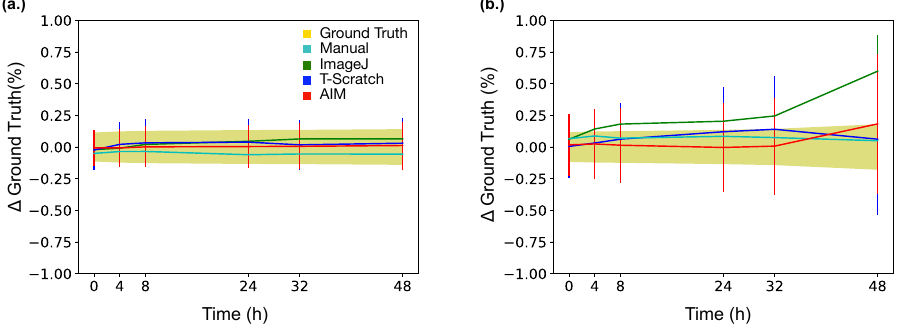
Figure 3. Representation of the average percentage difference from the ground truth as a function of time. In ( a ), the data relative to the control condition are shown; while in ( b ), the values computed for the TGF- β 1-treated cells are reported. The yellow shaded area represents the dataset’s variability and was computed as the standard deviation of the wound area obtained at every time point with the gold standard method.